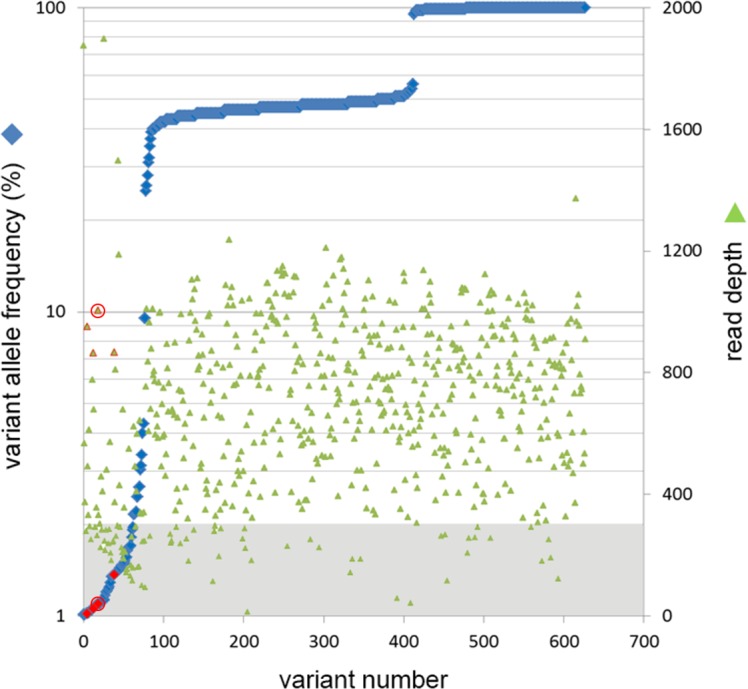
Variant allele frequency distribution in the peripheral lens epithelial sample from donor N146 (see Table 1). A total of 628 variants (blue diamonds) are detected with frequencies ranging from 1% to 100%. For each variant, the corresponding read depth is indicated (green triangle). Variants with frequencies of 50% or 100% represent heterozygous or homozygous SNPs, respectively. Seventy-eight low-allelic fraction (<10%) variants are detected. Many of the low-allelic fraction variants were not called as true somatic variants because they were associated with read depths of less than 300 (shaded area) or because they failed other quality control criteria (see Materials and Methods). Four variants (red diamonds) passed all filters (including sufficient read depth [red triangles]). The variant circled in red (the associated read depth value is also encircled in red) corresponds to a T > C substitution in the BRCA2 gene (see Table 5).